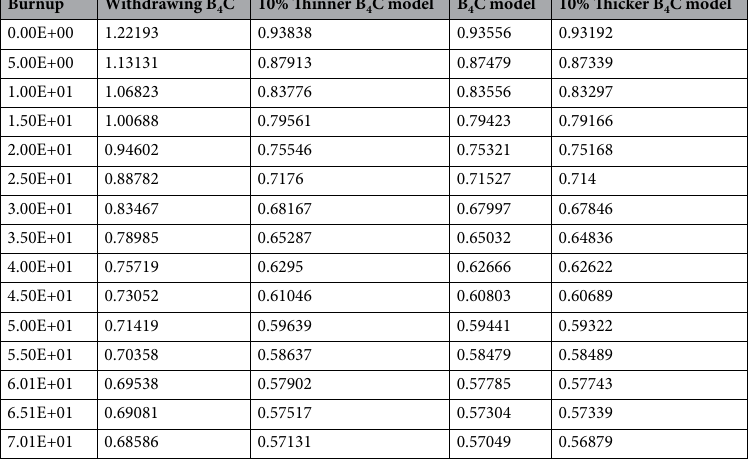
Table 3. Numerical values of K-eff with burnup for the 4 cases.